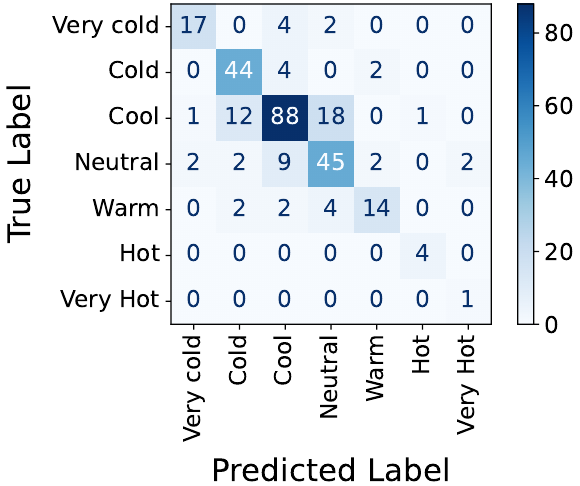
Figure 11. Confusion matrix for adult data.